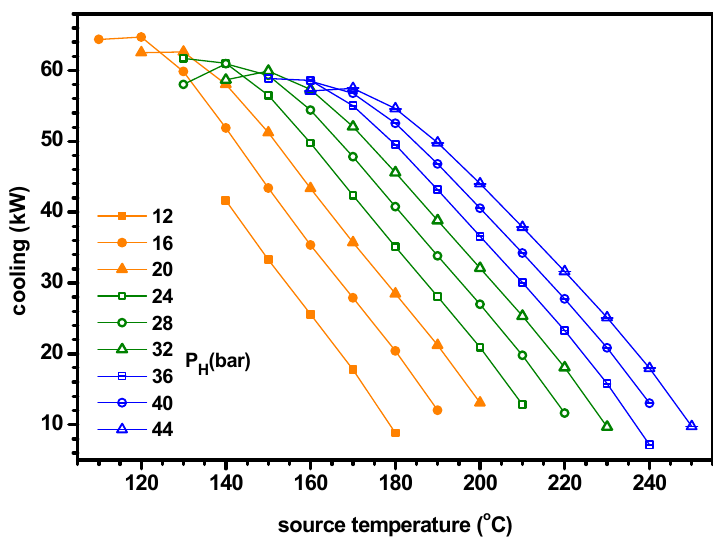
Figure 16. Effect of source temperature on the cooling capacity. Figure 16. E ff ect of source temperature on the cooling capacity.